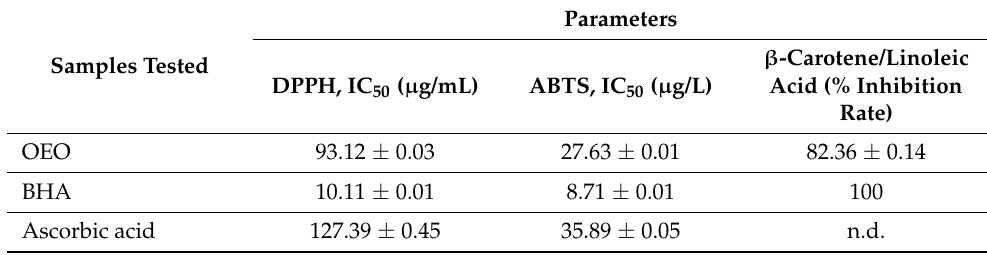
Table 3. The antioxidant activity of essential oil extracted from O. vulgare var. aureum . Parameters β -Carotene/Linoleic Samples Tested DPPH, IC 50 ( µ g/mL) ABTS, IC 50 ( µ g/L) Acid (% Inhibition